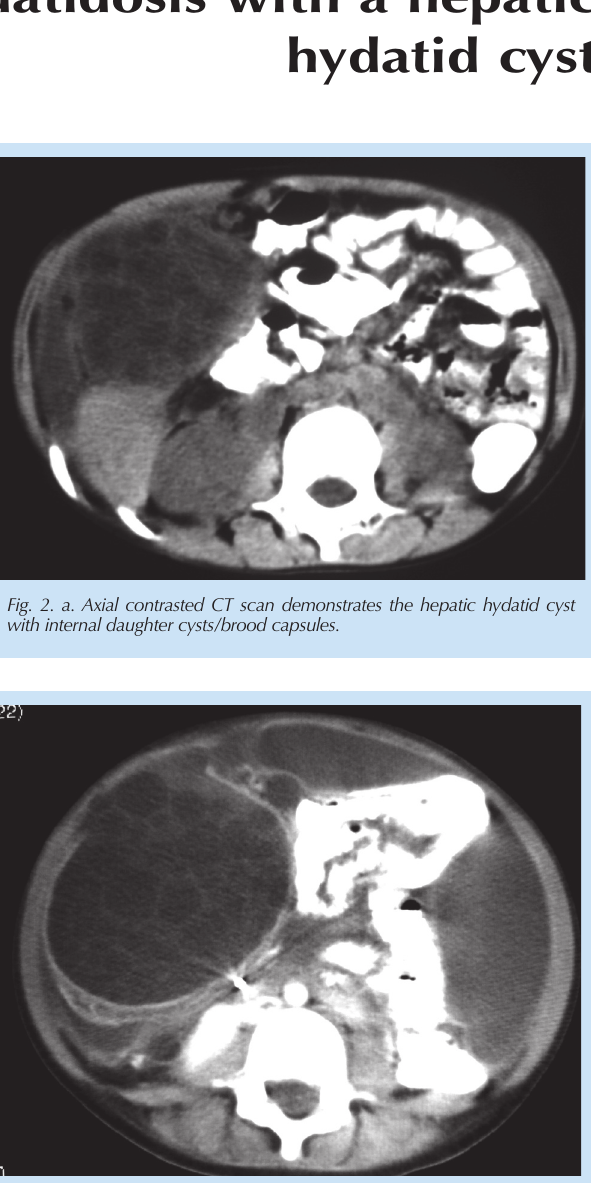
Fig.2b. The hydatid cyst projects beyond the liver margin inferiorly and has ruptured at its anterior